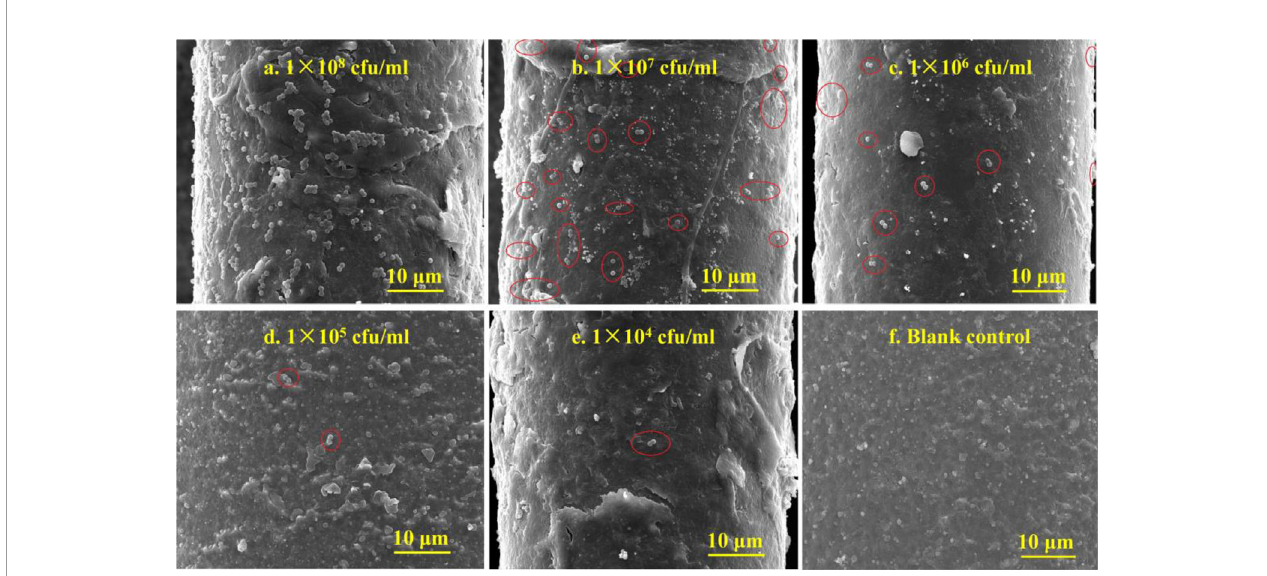
FIGURE 3 | The SEM images of the S. aureus captured by the antibody-immobilized optical fi ber probes. Figures (A – E) show the captured images of bacterial concentration from 1 × 10 8 to 1 × 10 4 CFU/ml respectively, while Figure (F) shows the blank control group without bacterial capture. The probes could capture more S. aureus with the increase of the concentration gradients of the S. aureus suspension.